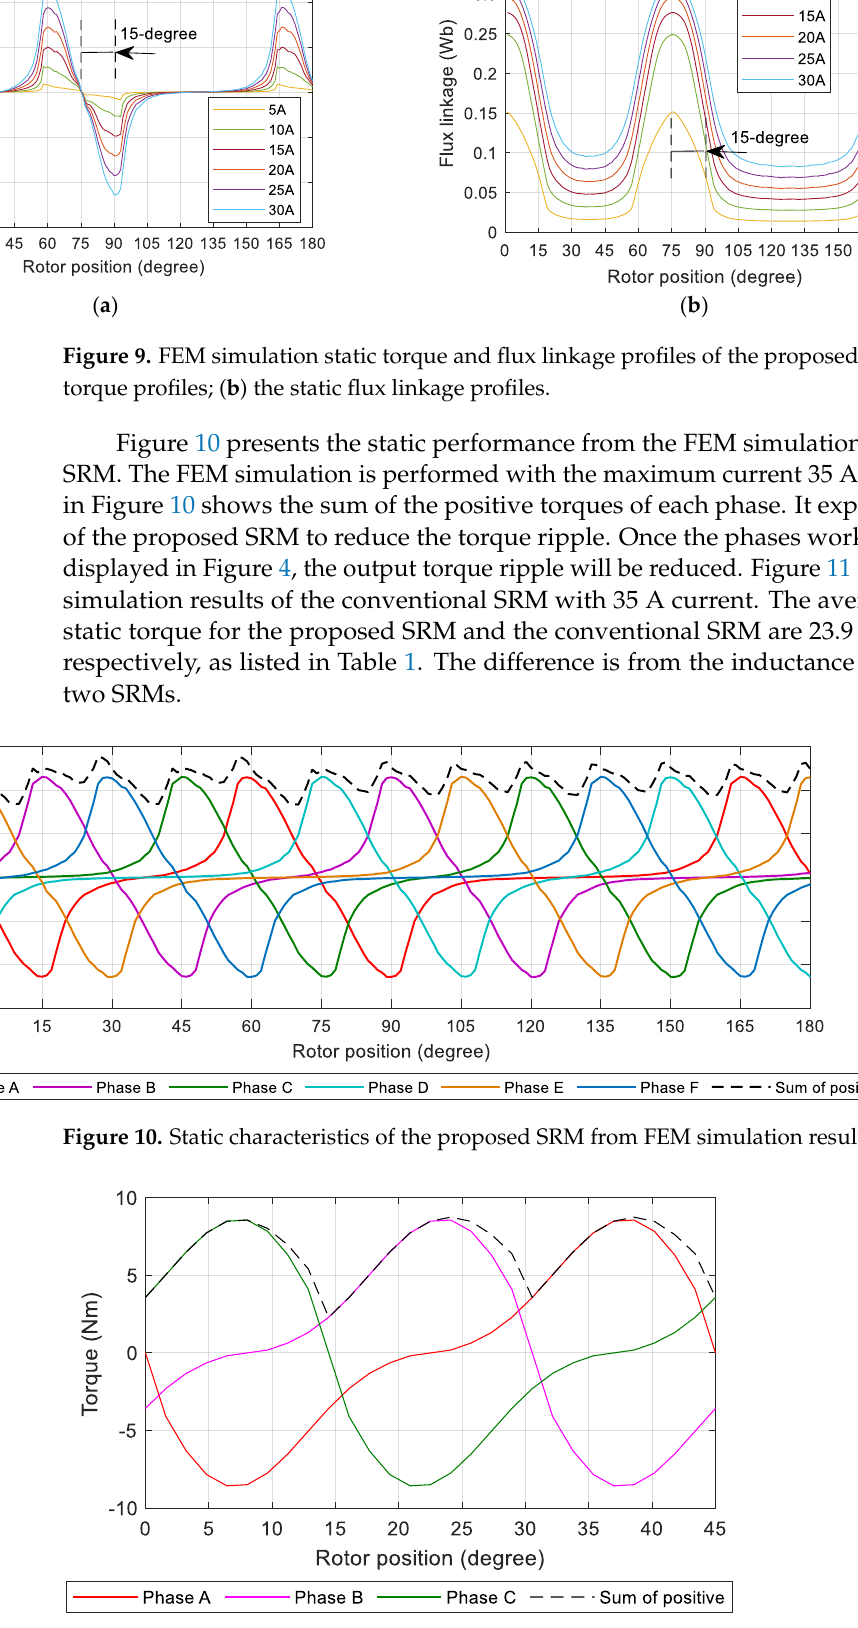
Figure 11. Static characteristics of the conventional SRM from FEM simulation results.